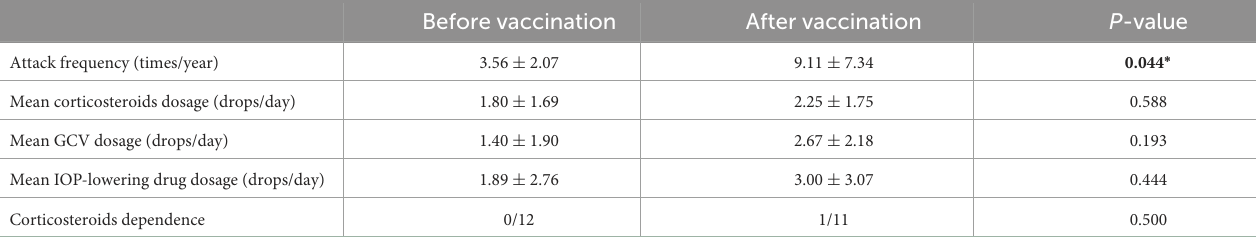
TABLE 3 The comparison of medication between relapses before and after COVID-19 vaccination. Before vaccination After vaccination P